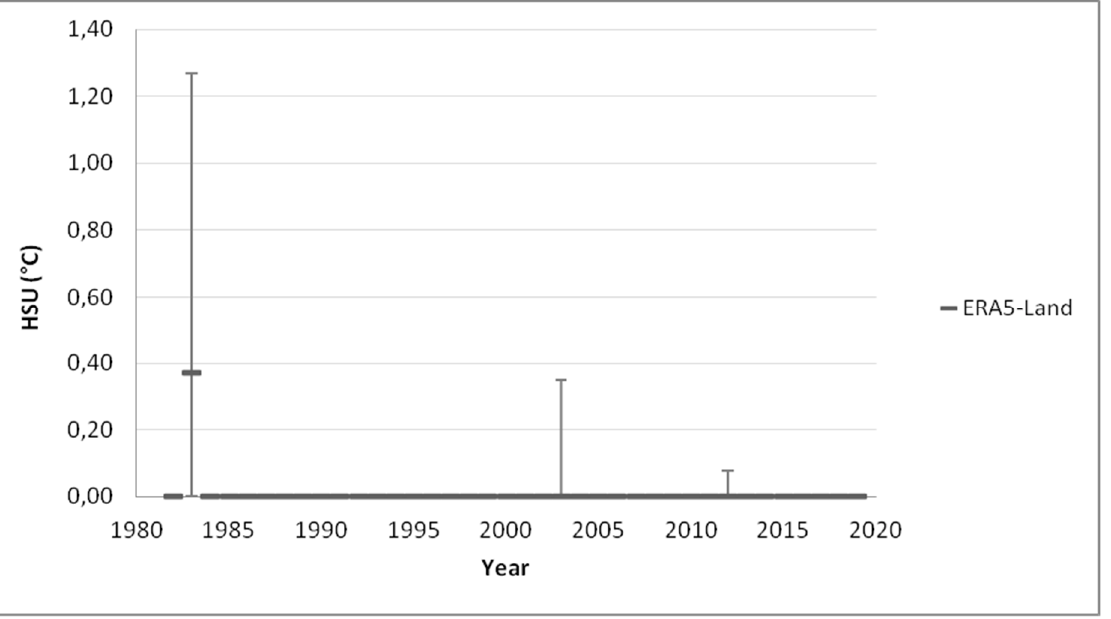
Figure 11. Graph of annual HSU for C3 crops between the years 1982 and 2019.